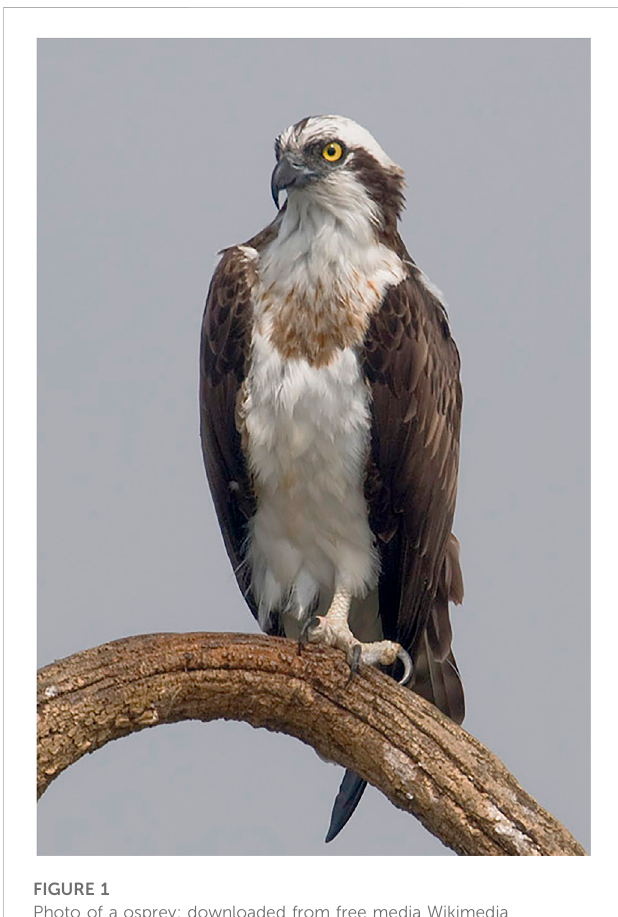
FIGURE 1 Photo of a osprey; downloaded from free media Wikimedia